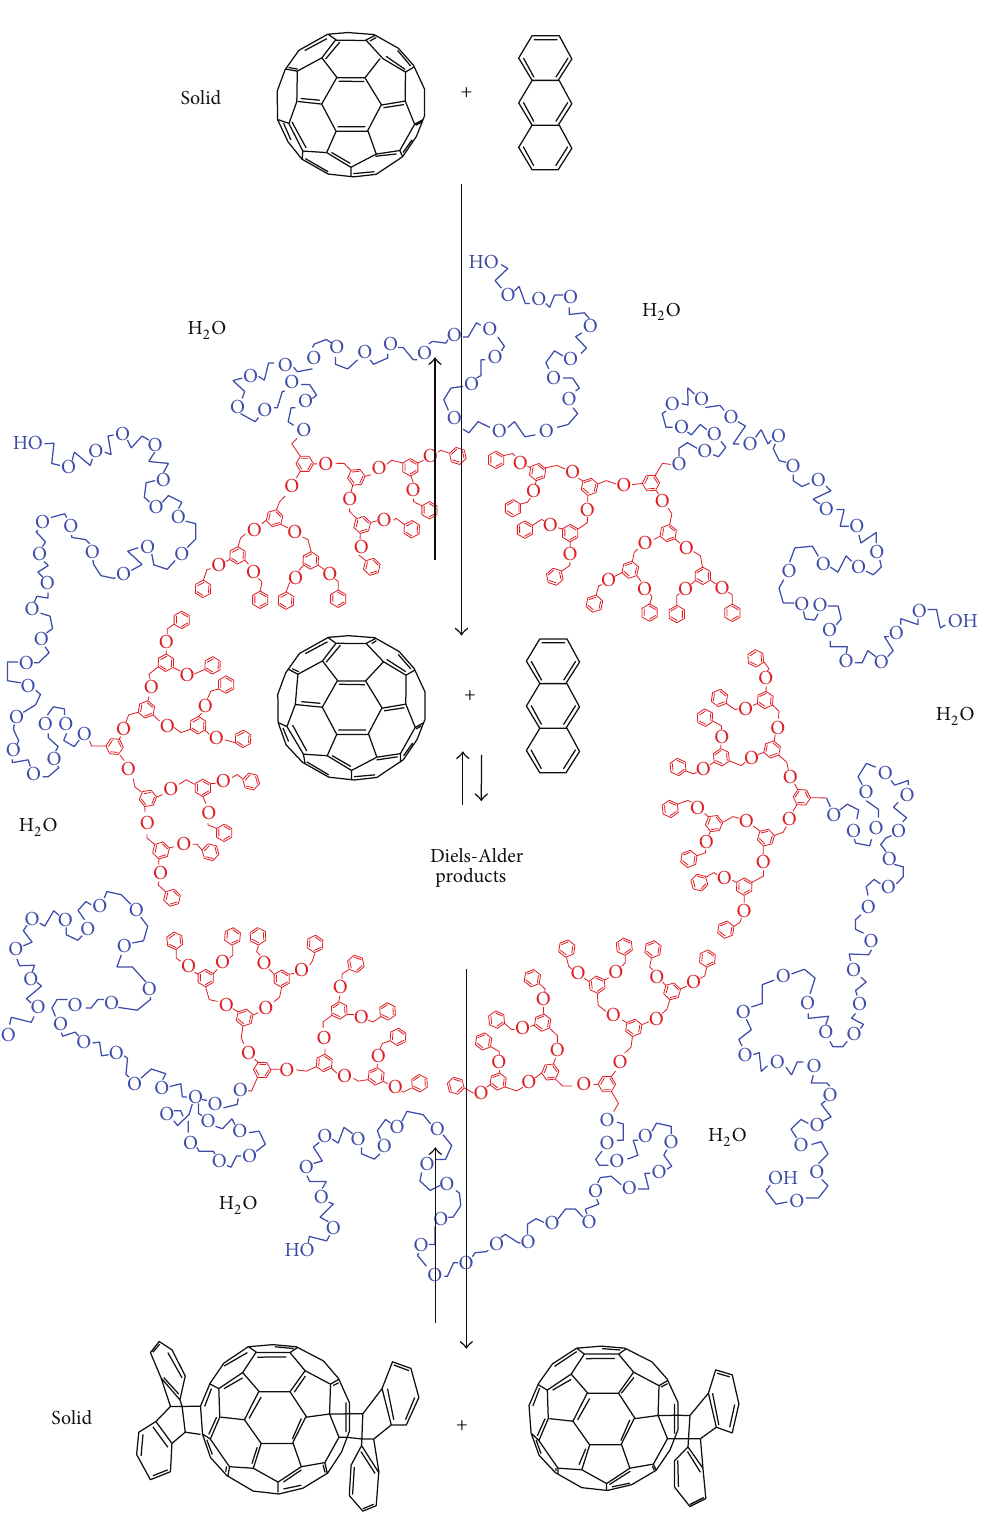
Figure 4: Mass transfer in and out of the micellar nanoreactor entity